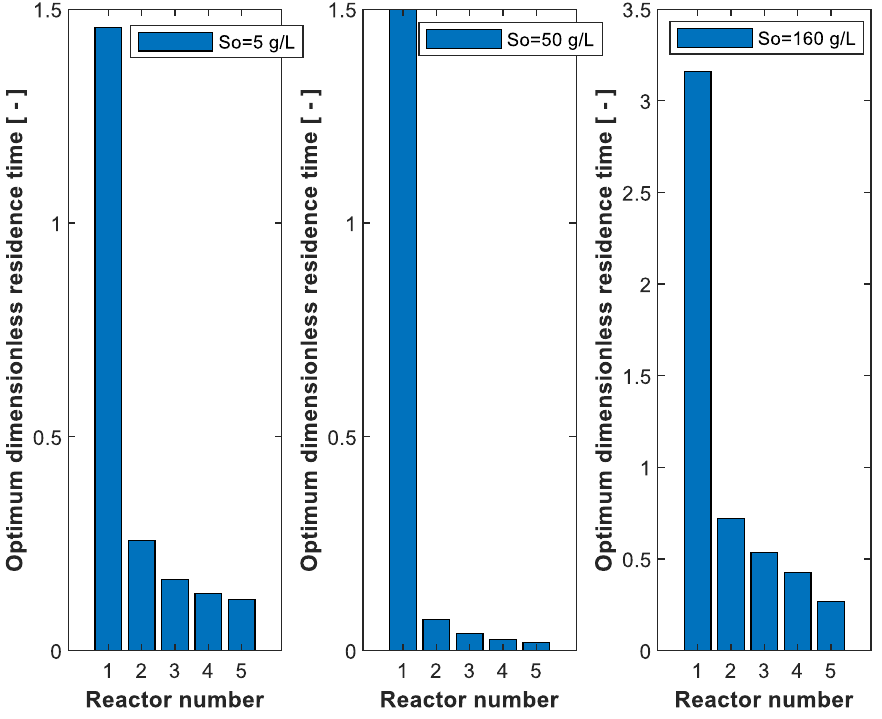
Figure 7. Optimum dimensionless residence time for 5 reactors connected in series at 3 feed substrate concentrations. Substrate conversion: 99%. X o = 0.01 g/L. P o = 0. concentrations. Substrate conversion: 99%. X o = 0.01 g/L. P o =